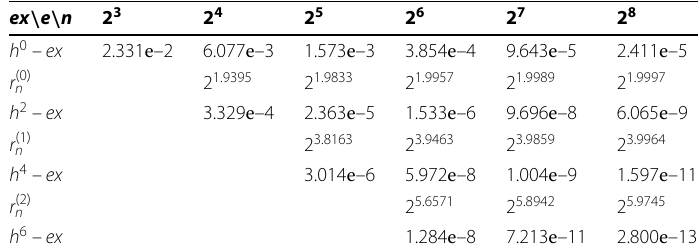
Table 1 The numerical results for t = 0.25